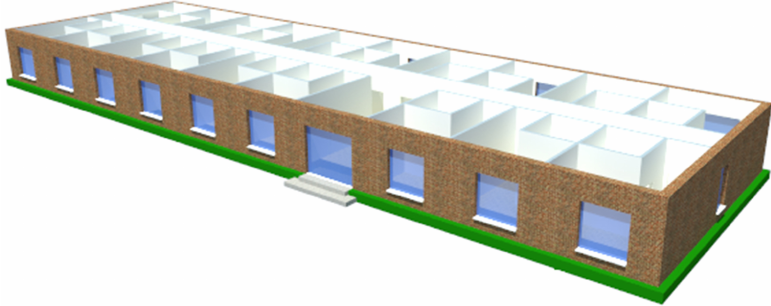
Figure 6. Free-standing hotel